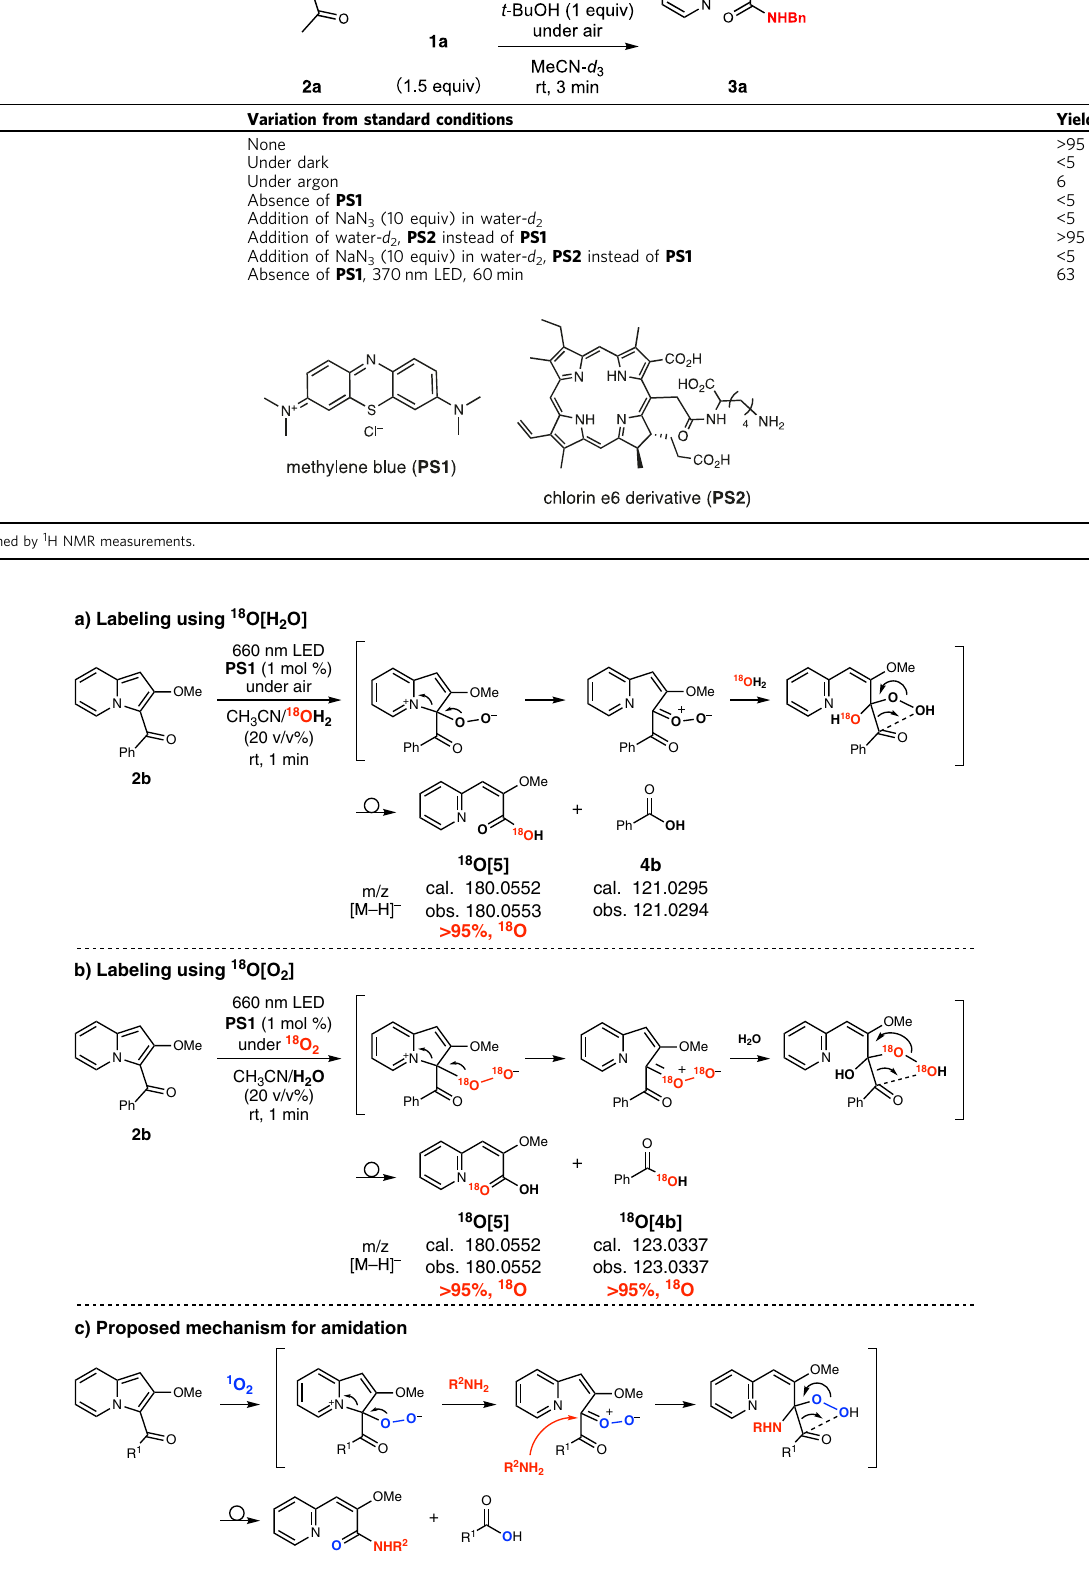
Fig. 2 Mechanistic studies. 18 O-Labeling using ( a ) 18 O[H 2 O] or ( b ) 18 O[O 2 ]. c Proposed mechanism for